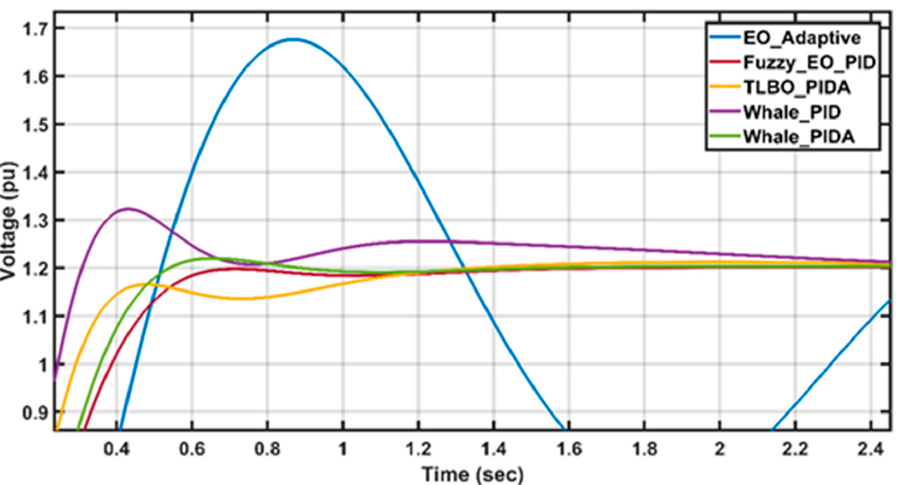
Figure 17. Tie power results for Kundur system.